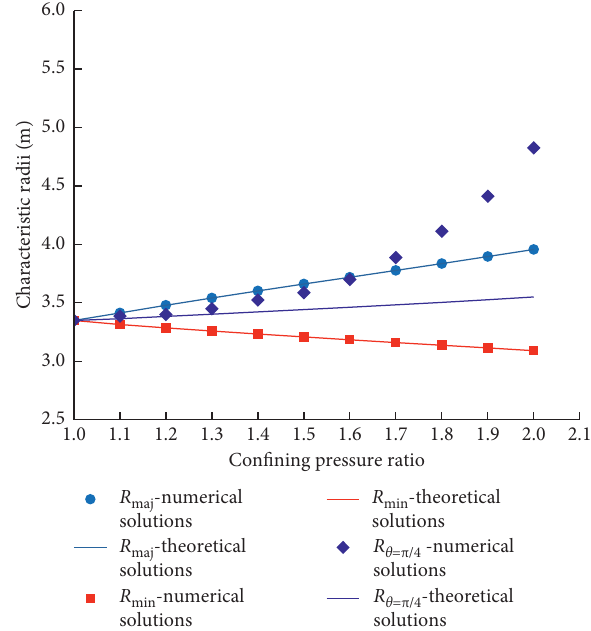
Figure 5: Error analysis for analytical solutions of special radii ( a � 2.5 m; C � 3 MPa; φ � 25 ° ; P 3 �